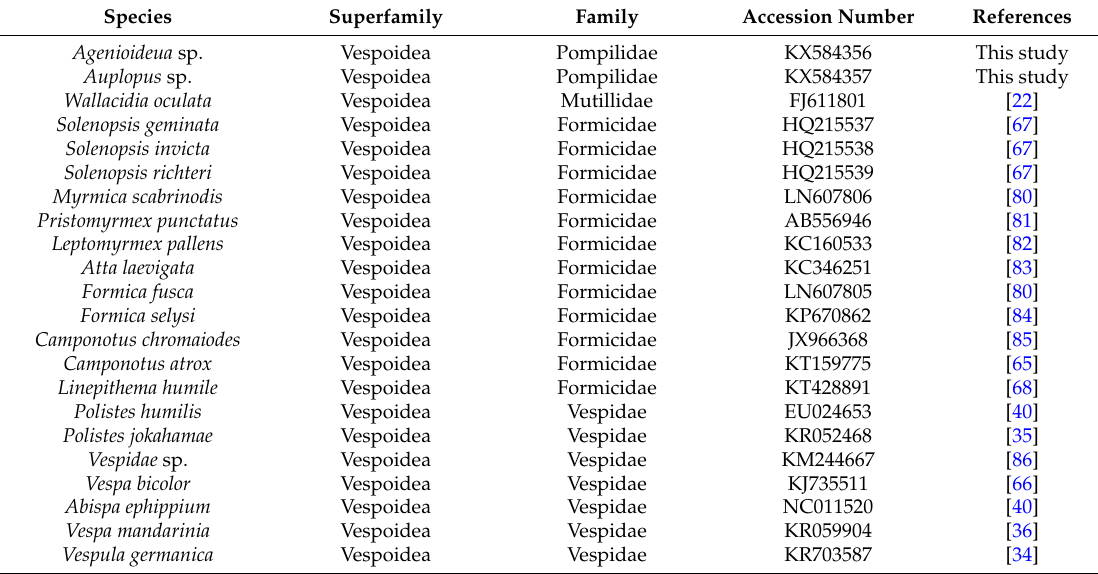
Table 4. The mitochondrial genomes currently sequenced in the different species of Vespoidea.